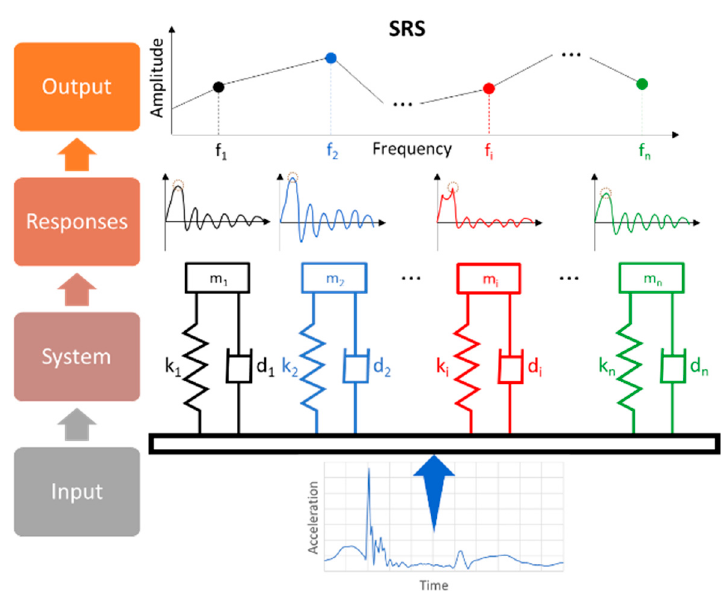
Figure 8. Workflow for SRS determination.